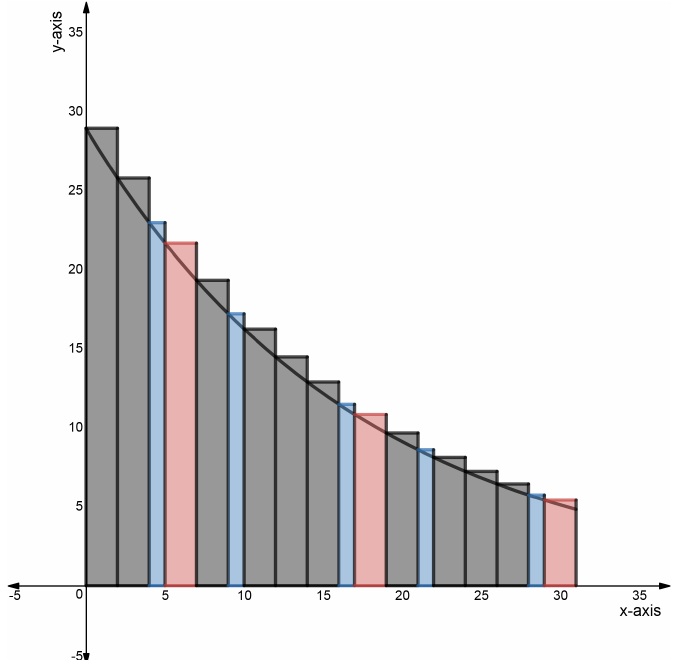
Figure 3. The curve in Equation (9) superimposed on the model of the Pan’s flute. The semitones, represented in blue, were adjusted to indicate the correct musical